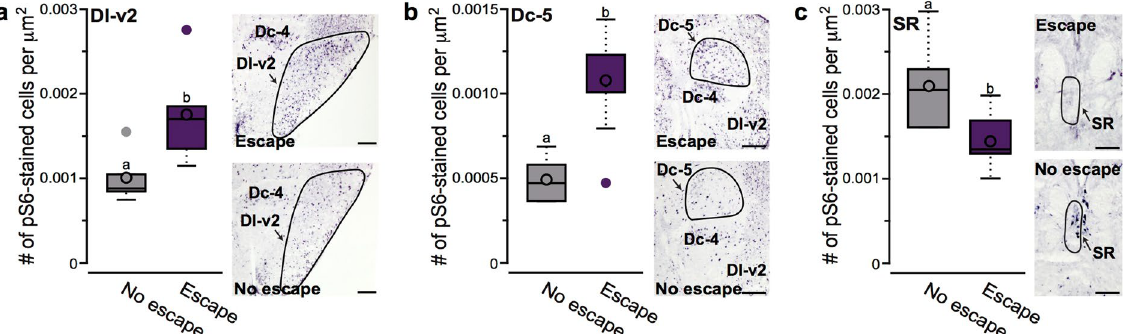
Figure 5. Escaping and non-escaping fish have different patterns of neural activation independent of collection day. ( a , b ) Escaping fish have higher activation in Dl-v2 and Dc-5 than non-escaping fish. ( c ) Non-escaping fish have higher activation in the SR compared to escaping fish. See Fig. 4 for box plot descriptions. Different letters represent statistical significance at P < 0.05. See text for abbreviations. Scale bars in a and b represent 100 μ m and 50 μ m in c.